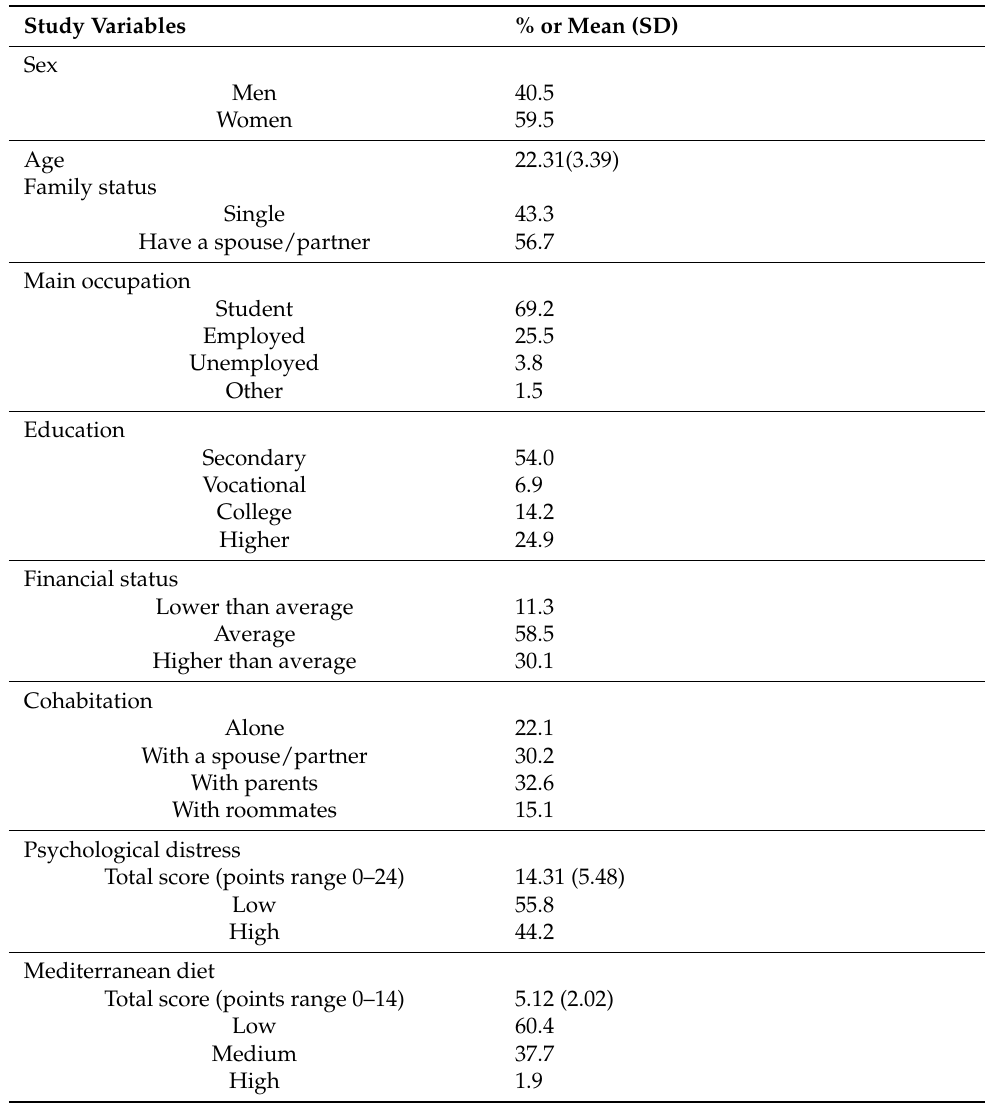
Table 1. Descriptive statistics of study